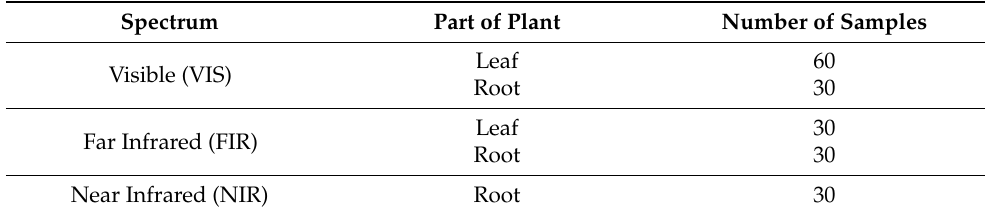
Table 1. Images obtained per capture session.